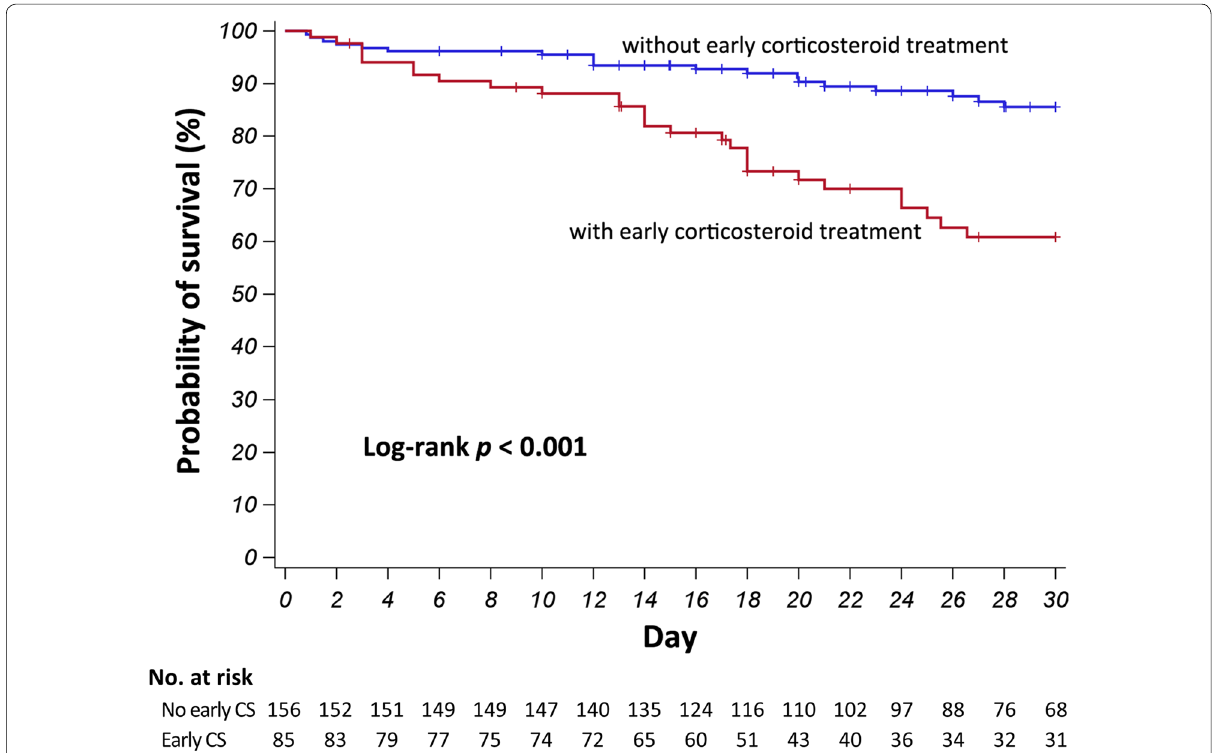
Fig. 2 Probability of survival from ICU admission to Day 30. The patients were classified by whether they received early corticosteroid (CS) treatment or not